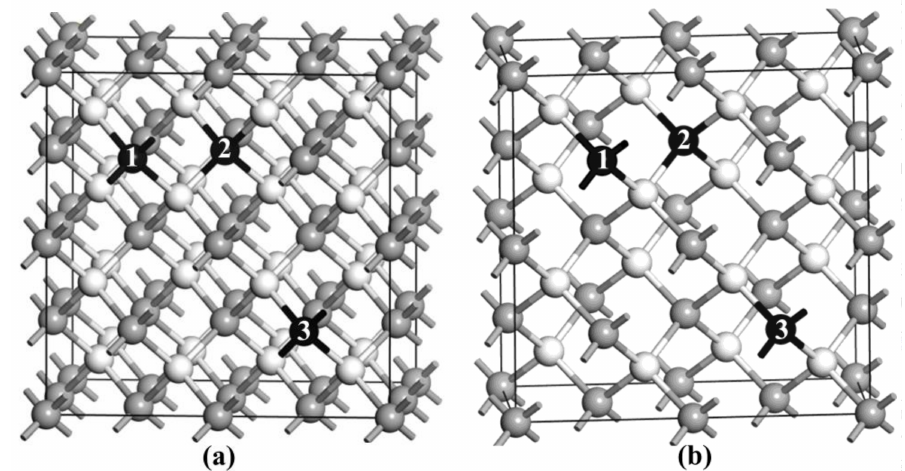
Figure 1. The crystal model of Ni-doped zinc-blende (ZB) ZnO (the gray and white balls indicate Zn and O atoms, respectively). The positions of Zn substituted by Ni are denoted by 1 and 2–3, ( a ) 2 × 2 × 2 supercell; ( b ) 1 × 2 × 2